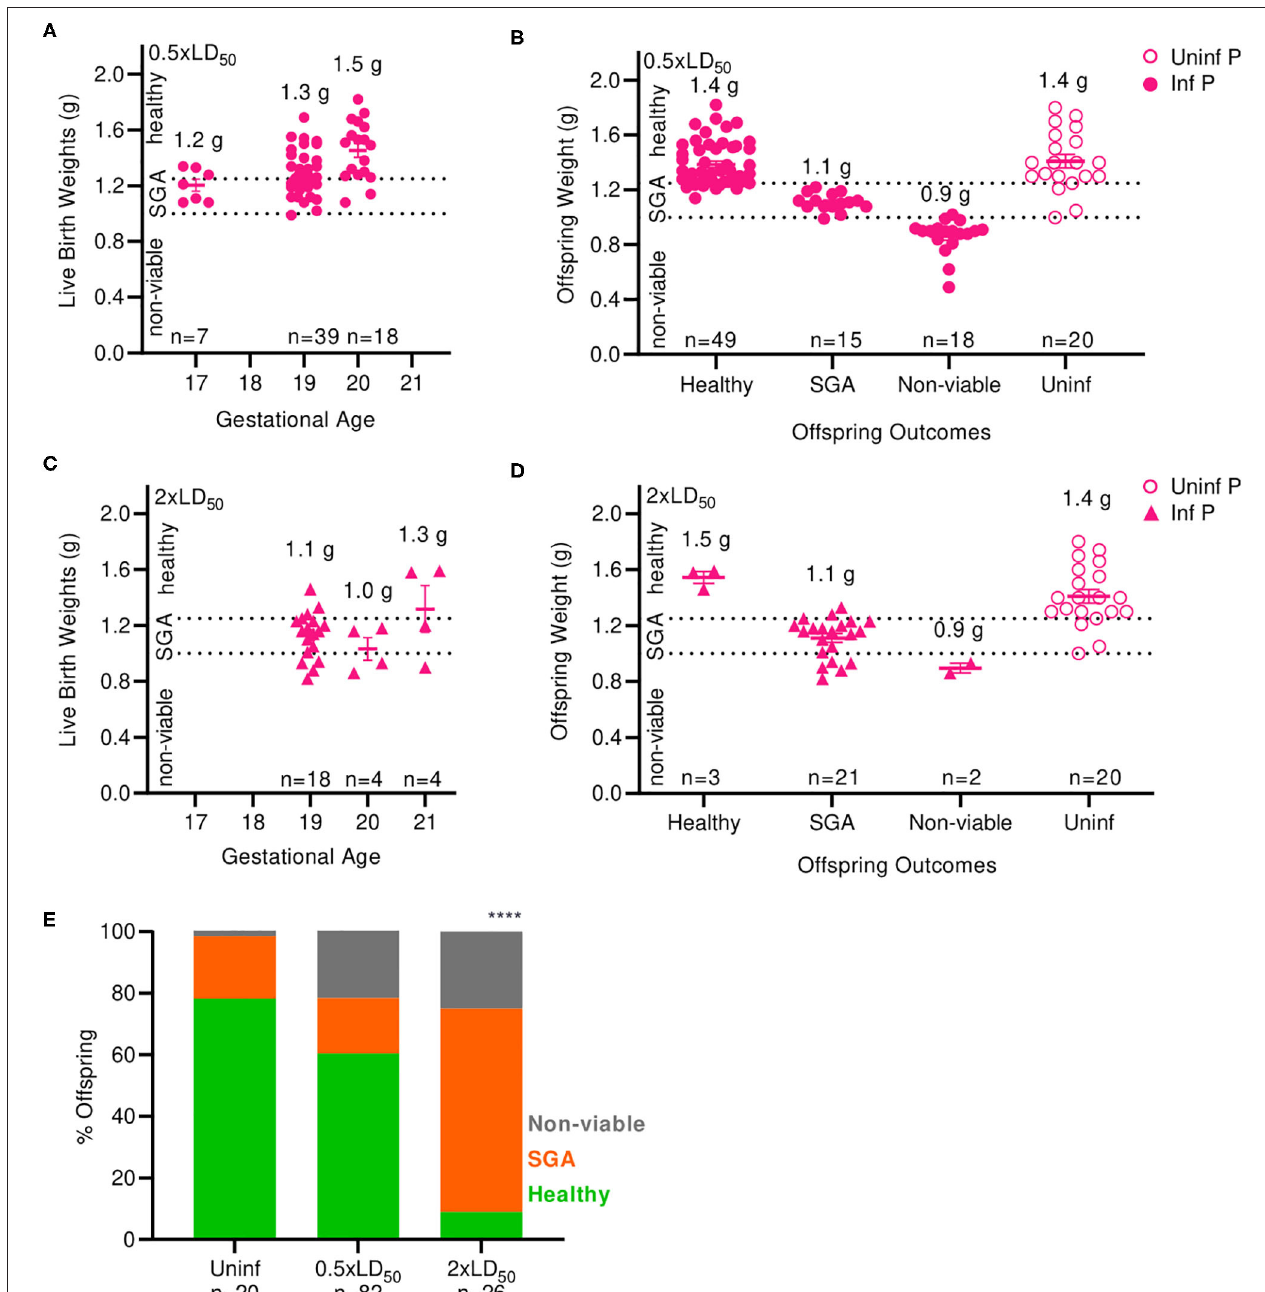
FIGURE 2 | Maternal influenza infection inhibits offspring development and health. (A) Birth weights of live offspring were recorded from dams infected with 0.5xLD50. Numbers denoted above data clusters represent the average. (B) Offspring weights from 0.5xLD50 infections were recorded at the time of birth, including stillborn or live pups. (C) Birth weights of live offspring were recorded from dams infected with 2xLD50. Numbers denoted above data clusters represent the average. (D) Offspring weights from 2xLD50 infections were recorded at the time of birth, including stillborn or live pups. (E) Offspring health status at time of birth is plot as a percentage of all pups from mothers of either 0.5- or 2xLD50 infections. Numbers denoted above data clusters represent the average. Error bars represent Standard Error of Mean (SEM) for all graphs. Offspring health status was analyzed using Chi-Square test. **** p < 0.0001.